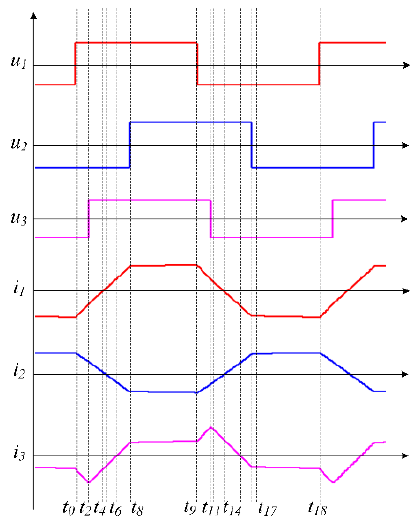
Figure 6. Simulated steady-state waveforms of TPI bidirectional DC/DC converter.